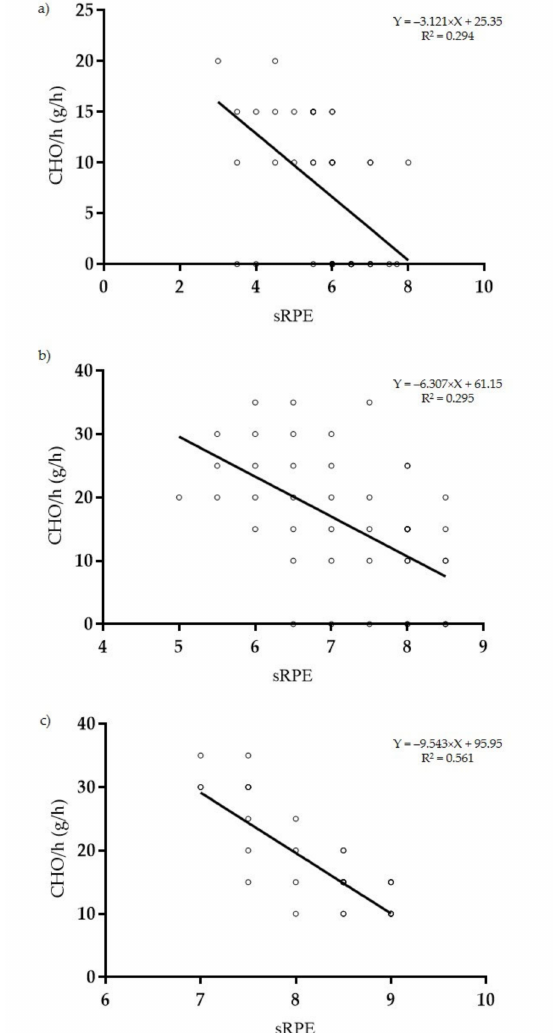
Figure 4. Linear regression between sRPE (AU) and training session carbohydrates consumption (gCHO/h) of training sessions displaying <100 TRIMP points ( a ); 100–200 TRIMP points ( b ) and >200 TRIMP points ( c ).